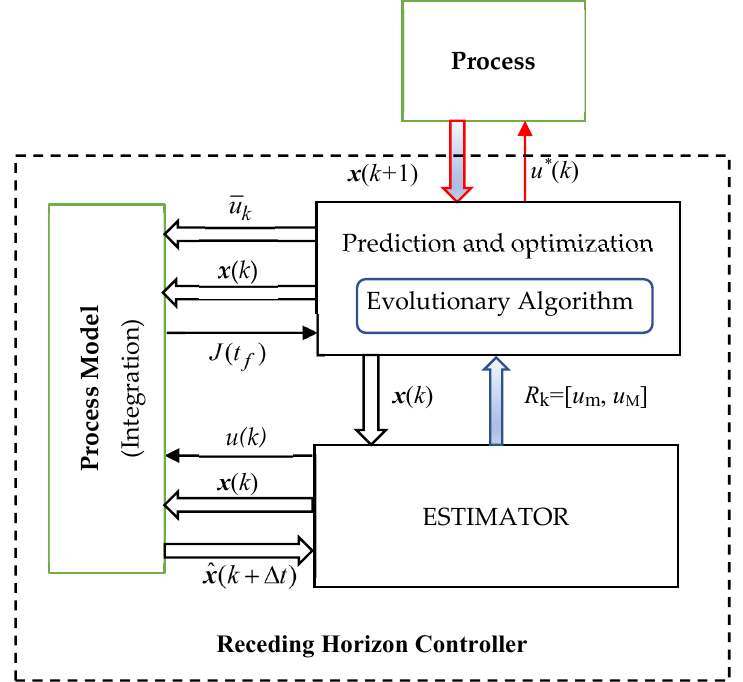
Figure 2. Receding horizon controller with ESTIMATOR.